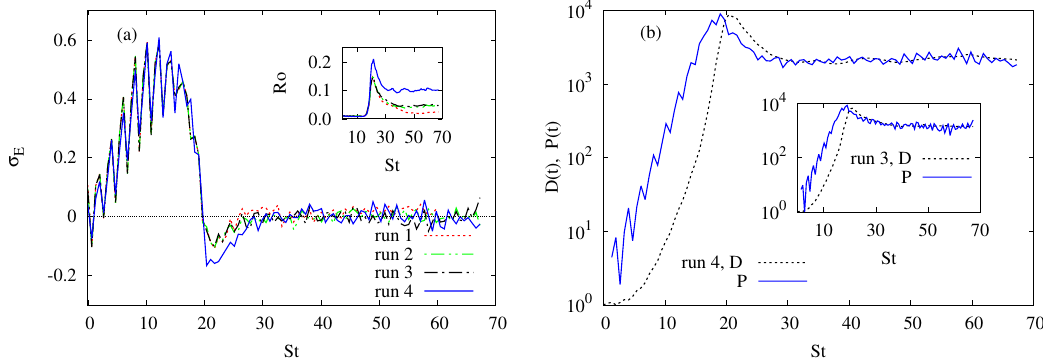
Figure 3. ( a ) Time development of the growth rate of total (kinetic + magnetic) energy (see Equation (27)) in the precessing hydrodynamic turbulence (PHT) case (run 1) and the precessing MHD turbulence (PMHDT cases) (runs 3–4). The inset shows the time development of the Rossby number Ro (see Equation (25)) for the same runs. ( b ) Time development of total (kinetic + magnetic) dissipation rate, D and total production rate, P in the precessing MHD turbulence (PMHDT) case with B = 2.5 (run 4). The results reported in the inset characterize the case where B = 0.5 (run 3).